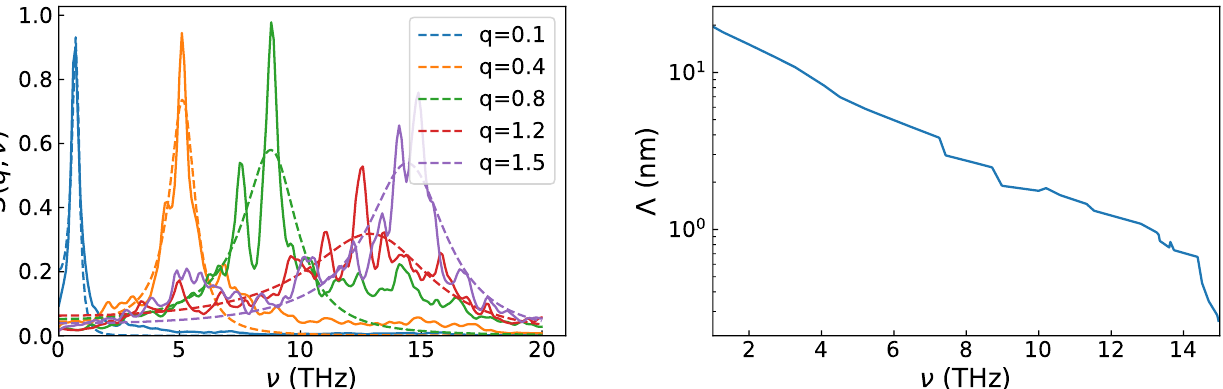
Figure A1. S η ( q , ω ) as fitted from Equation (A1) ( left ) and resulting MFP ( right ) for the NW-M configuration for the longitudinal